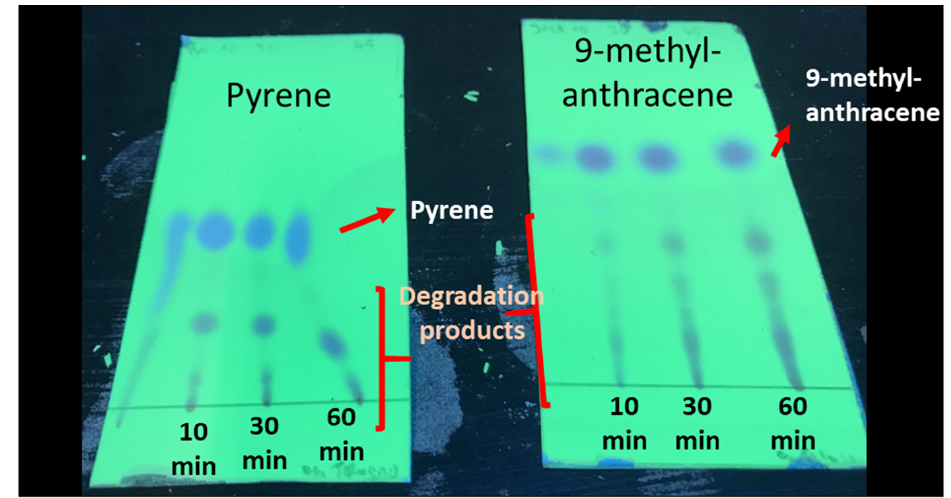
Figure 2. TLC chromatograms of the pyrene (left) and 9-methylantracene (right) toluene solutions treated by ozone in the homogeneous experiments for 10, 30 and 60 min. The images were acquired under UV radiation (254 nm).